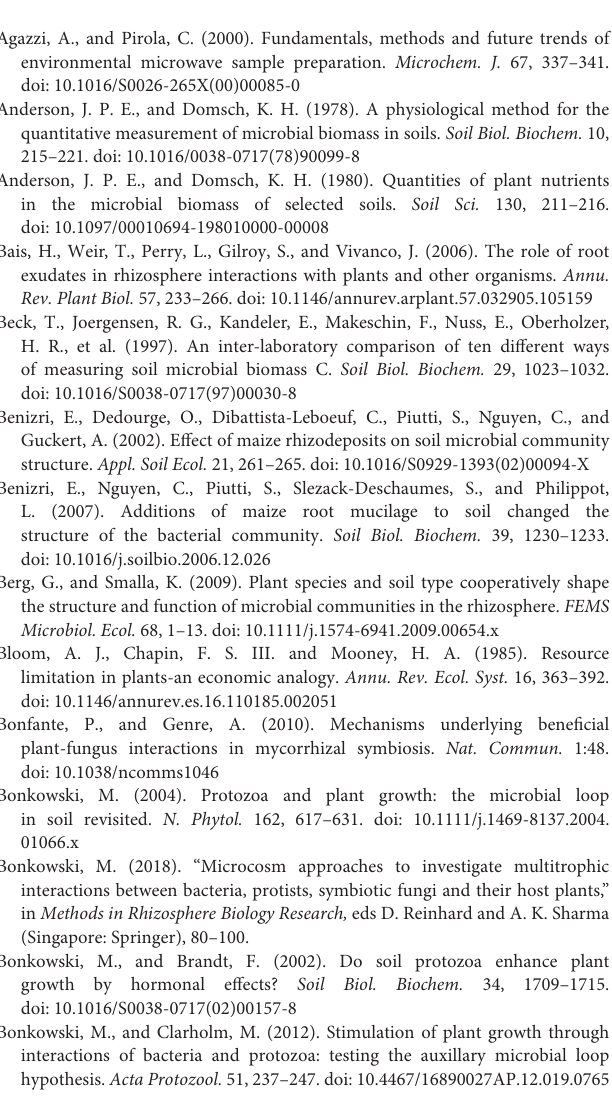
Figure S3 | Concentration of N (%) in shoots and in roots of both root chambers in control plants (0-0), plants treated with protists in the right root chamber (0-P), or treated with mycorrhiza in the right root chamber (0-M), or treated with protists and mycorrhiza together in the right root chamber (0-PM), or where the left and right root chambers were separately treated with protists and mycorrhiza (P-M). Means and standard deviation; horizontal lines denote significant contrasts with ( ∗ ) p < 0.1, ∗ p < 0.05, ∗∗∗ p < 0.001. Figure S4 | Concentration of P (%) in shoots and in roots of both root chambers in control plants (0-0), plants treated with protists in the right root chamber (0-P), or treated with mycorrhiza in the right root chamber (0-M), or treated with protists and mycorrhiza together in the right root chamber (0-PM), or where the left and right root chambers were separately treated with protists and mycorrhiza (P-M). Means and standard deviation; horizontal lines denote significant contrasts with ( ∗ ) p < 0.1, ∗ p < 0.05. Table S1 | Correlation of single PLFAs with the major axes of the DFA ( Figure 4 ). Significant correlations ( p < 0.05) are shown in bold.